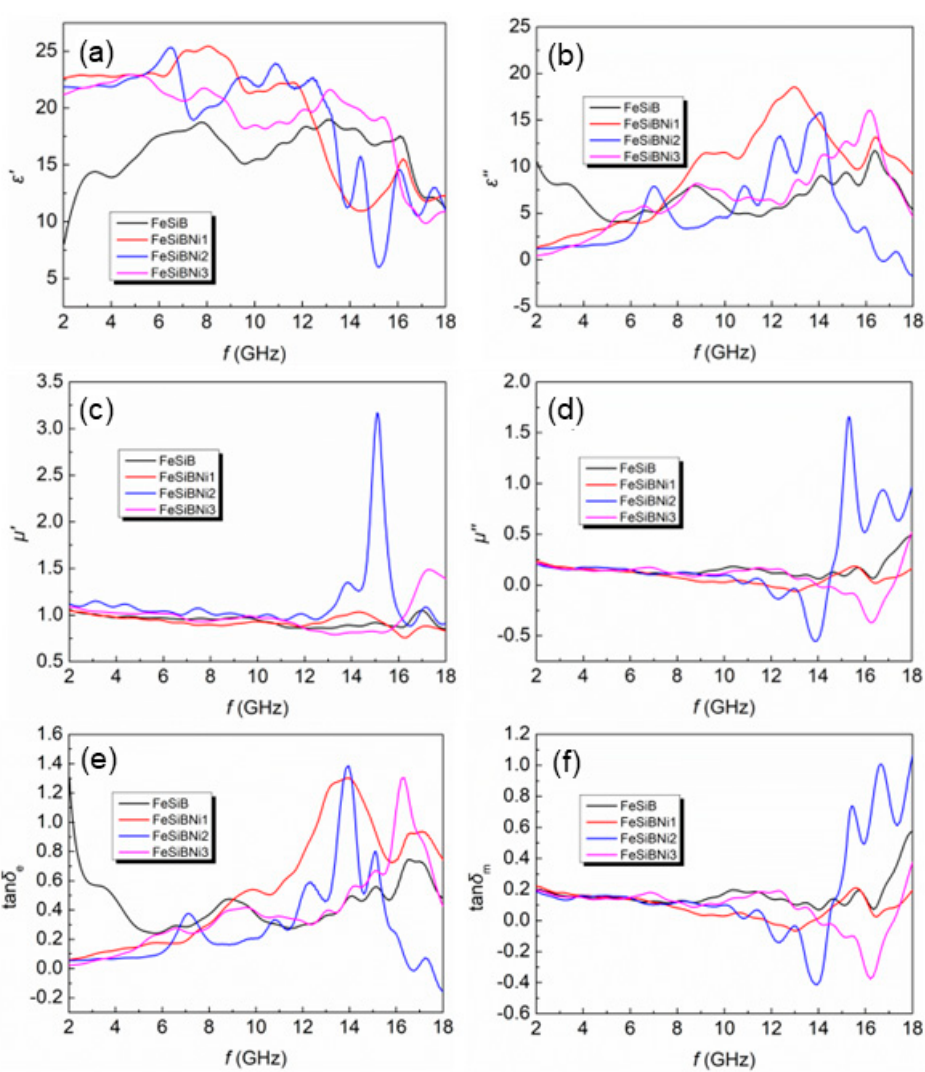
Figure 7. Frequency dependence of electromagnetic parameters of as-prepared Ni–doped Fe–based metallic microwires/paraffin matrix composites at 2–18 GHz: ( a ) ε ′ ; ( b ) ε ′′ ; ( c ) μ ′ ; ( d ) μ ′′ ; ( e ) tan δ e ; ( f ) tan δ m.